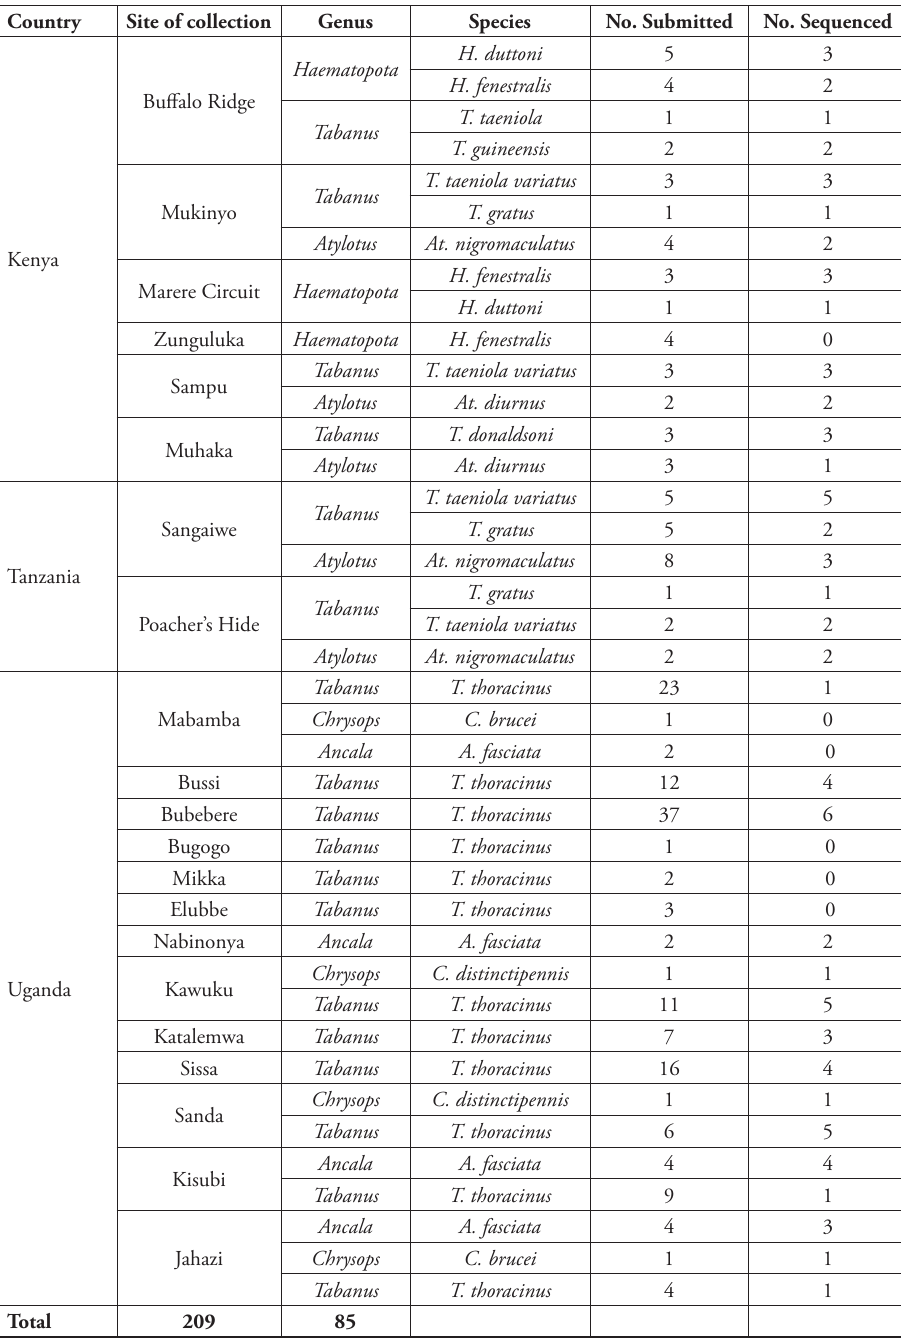
Table 2. Samples of each morphological identification that were submitted for sequencing from each locality per